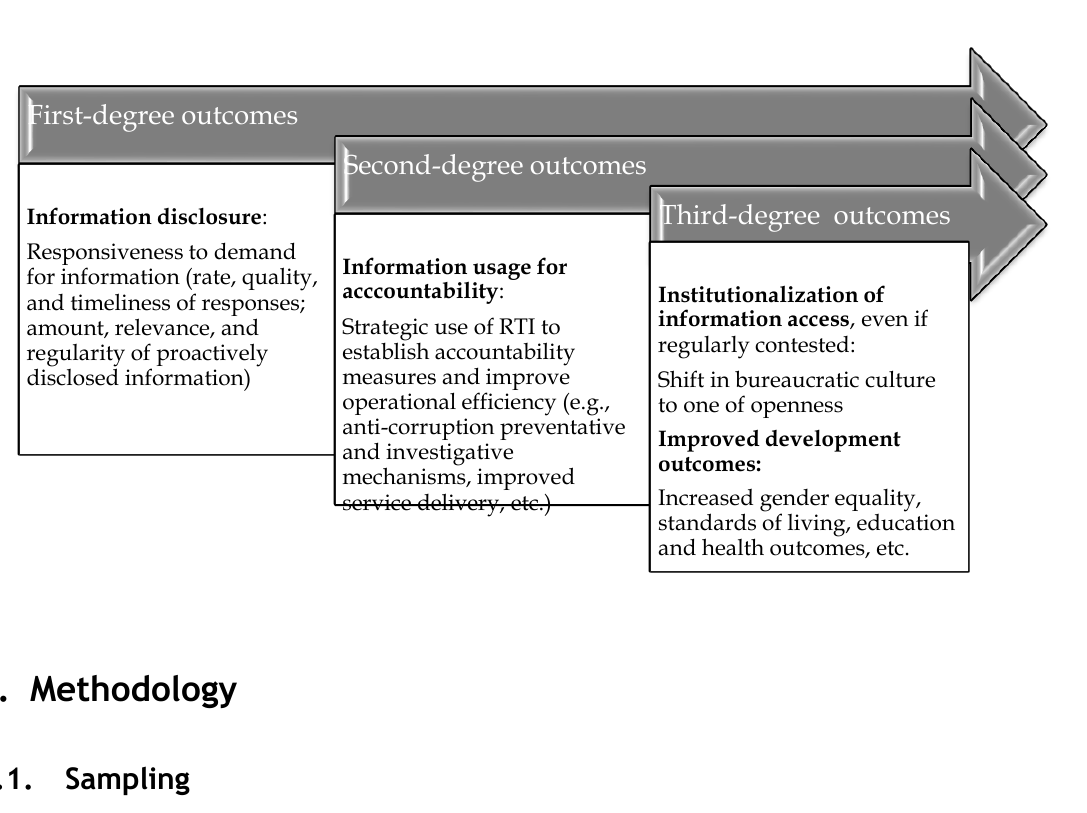
Figure 1: Degrees of RTI Outcomes (Trapnell and Lemieux